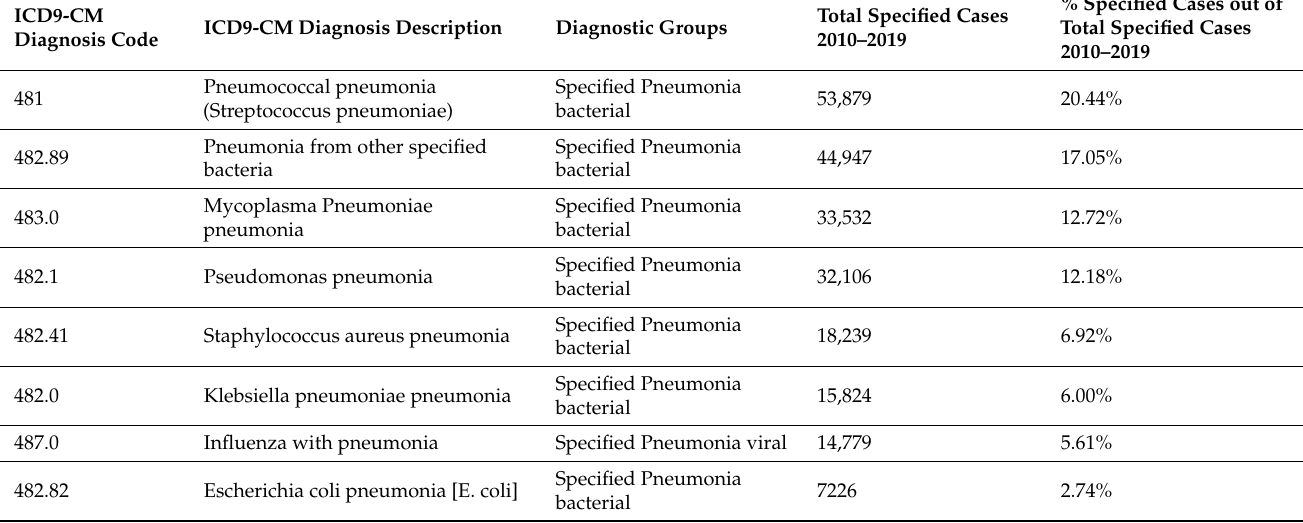
Table 2. Absolute and relative frequencies of specified bacterial, viral and fungal